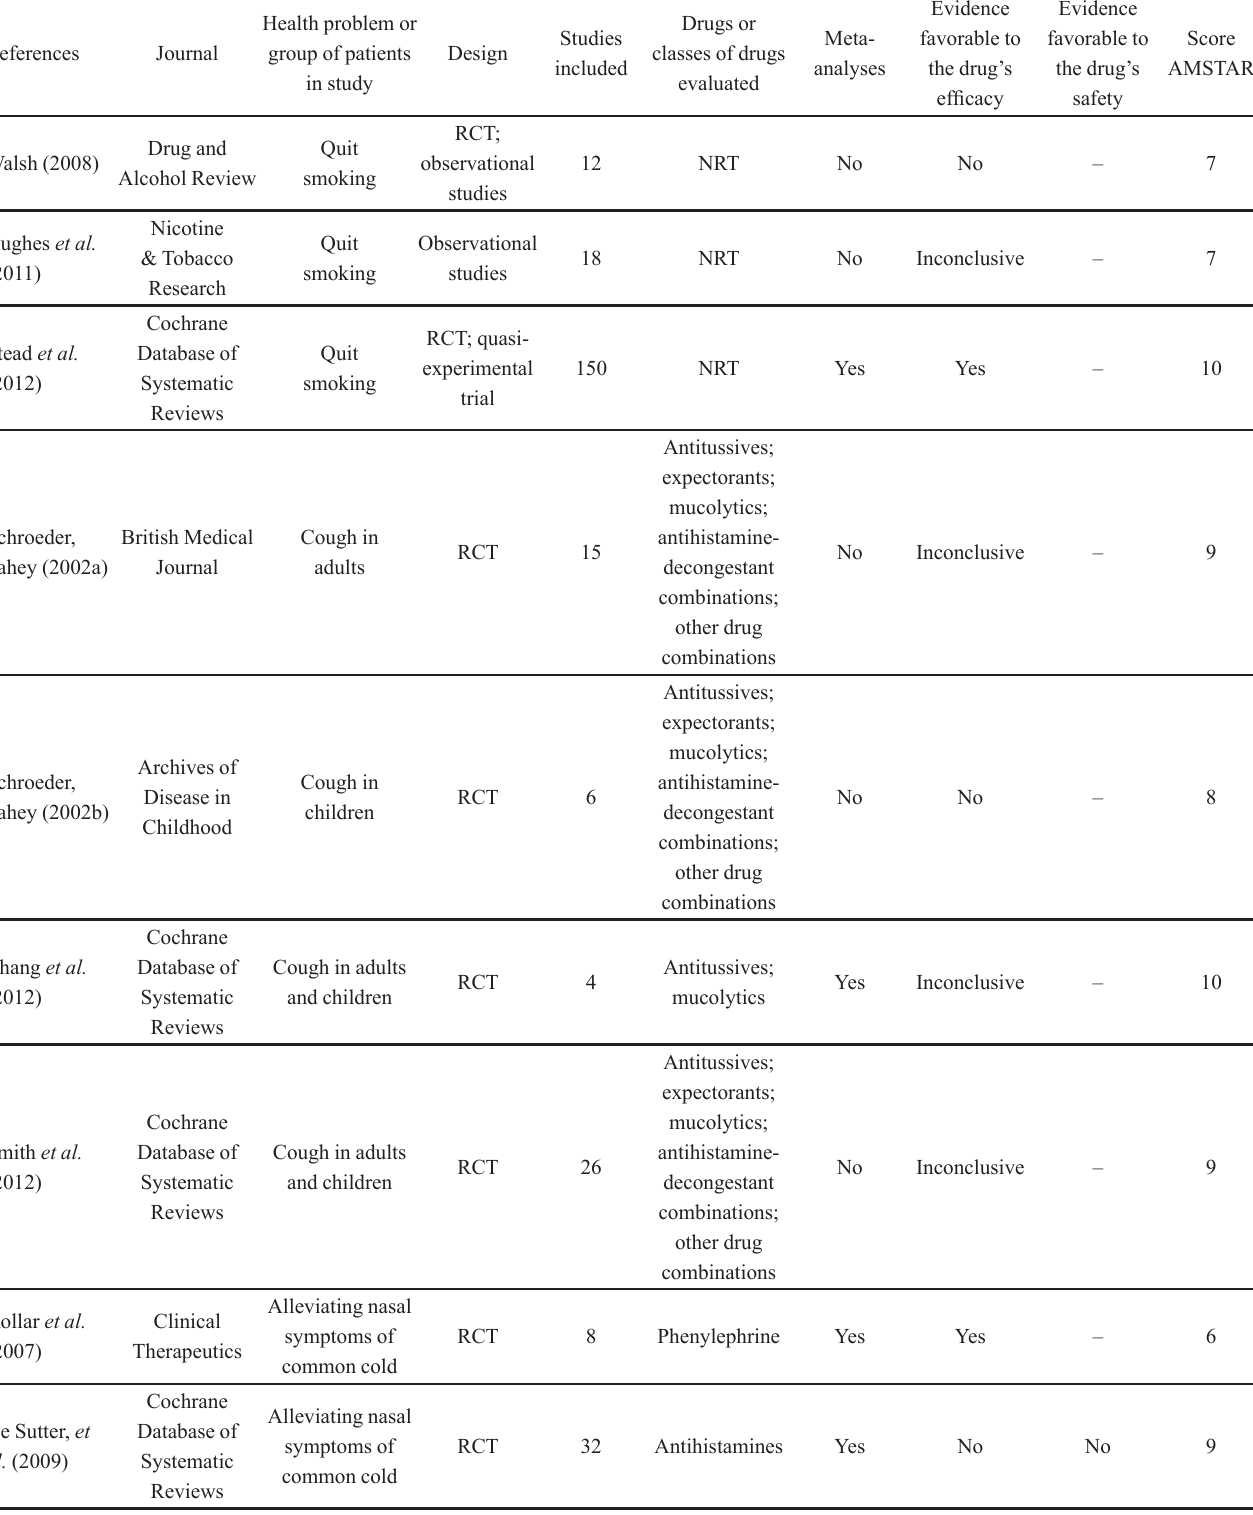
TABLE I - Main characteristics of systematic reviews on OTC drugs